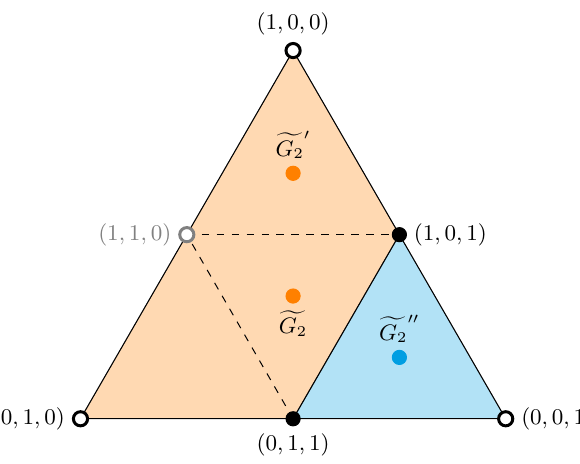
by an affine R 2 plane orthogonal to the vector (1 , 1 , 1) . This cross > 0 and its boundary into W-cells for the topological graph model > 0